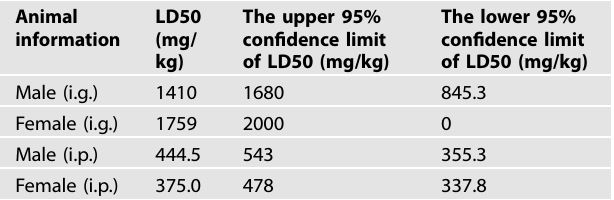
Table 1. Lethal dose (LD50) and toxicity grade of I3C in mice. Animal information